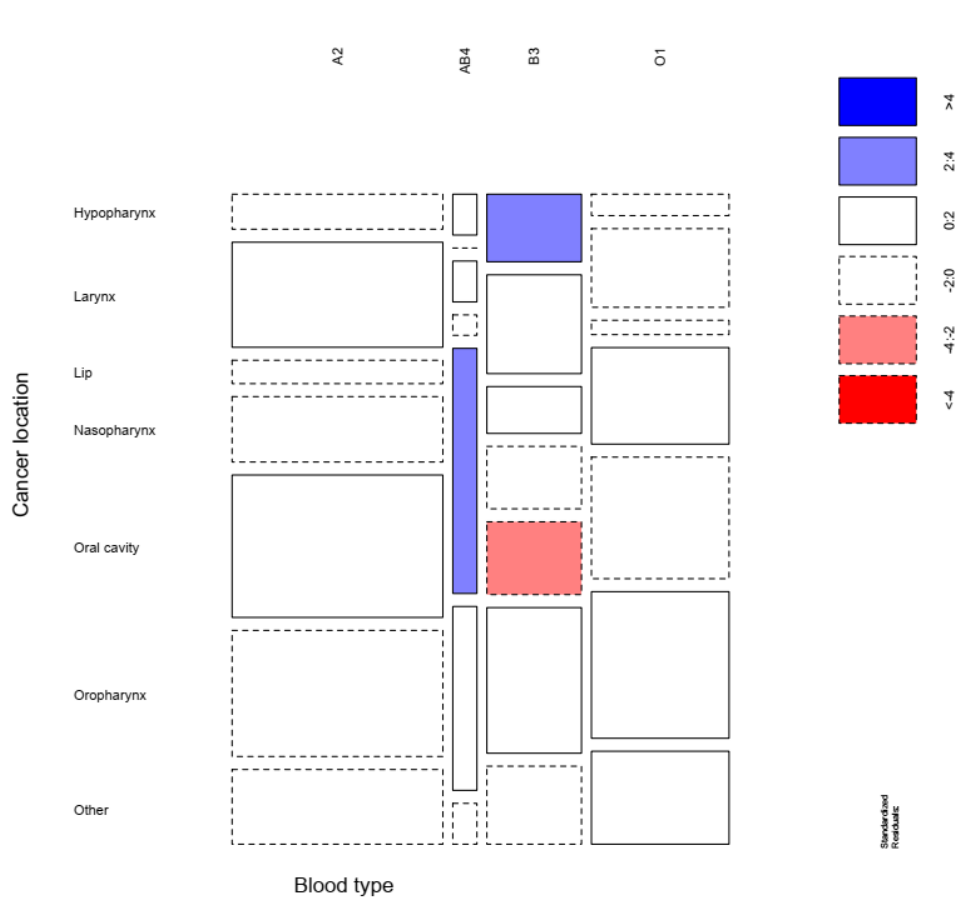
Figure 1. Higher hypopharynx cancer was associated with B group, oral cavity cancer was associated with a lower risk in patients with B group, while AB patients had a higher risk for oral cavity cancer.